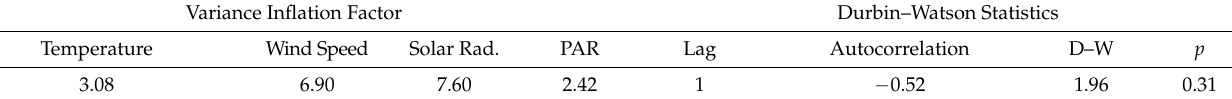
Table 8. Results of regression analysis of experimental site (1000 trees/ha). Multiple Linear Regression and F-Test of Model 1 and Model